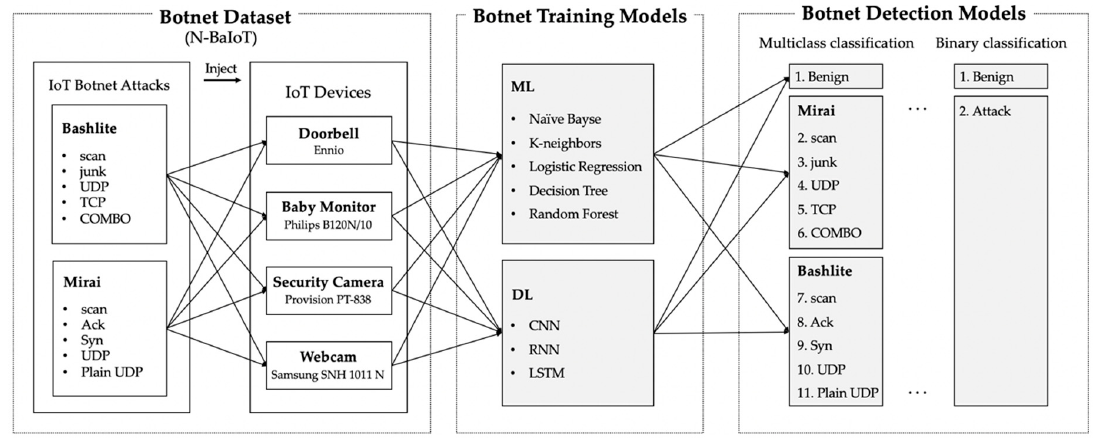
Figure 1. Our proposed framework for IoT botnet detection.